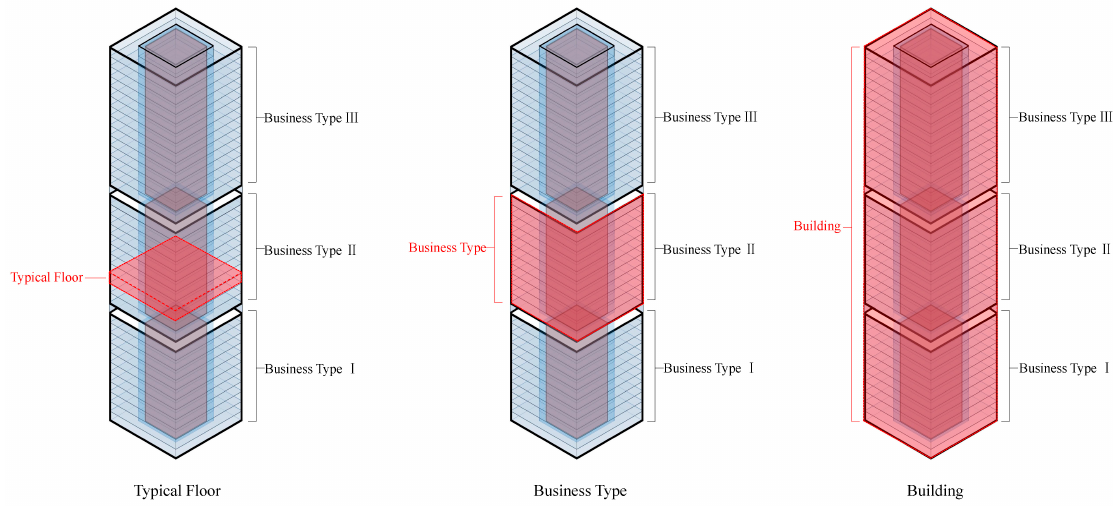
Figure 2. Schematic diagram of the three research indicator levels (i.e., typical floor, business, and building).